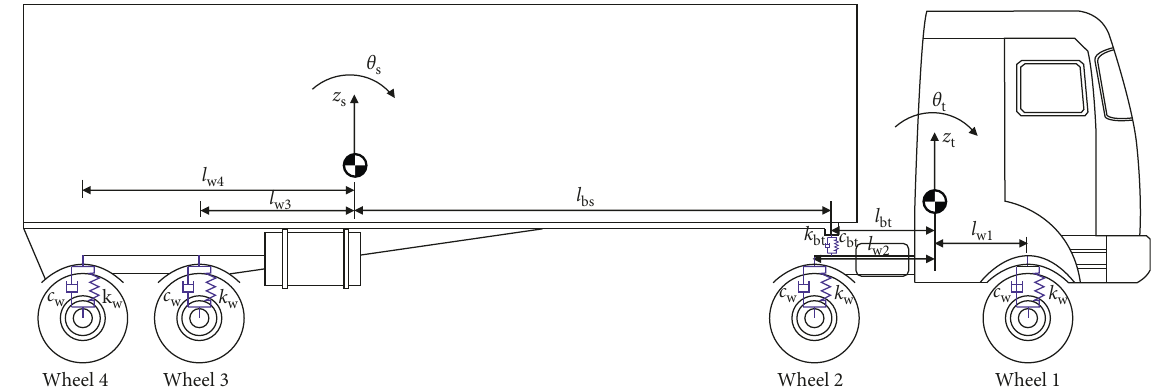
Figure 10: Schematic drawing of vehicle